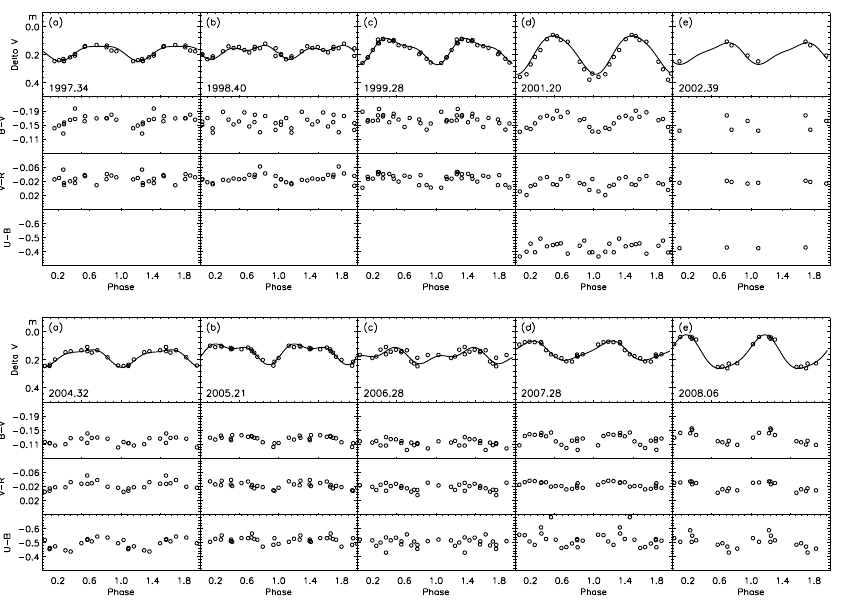
Fig. 1. The V light curve and U – B , B – V and V – R color curves obtained for 1997– 2008 at the Ege University Observatory. The synthetic curves derived from the period analysis of seasonal observations are shown by solid